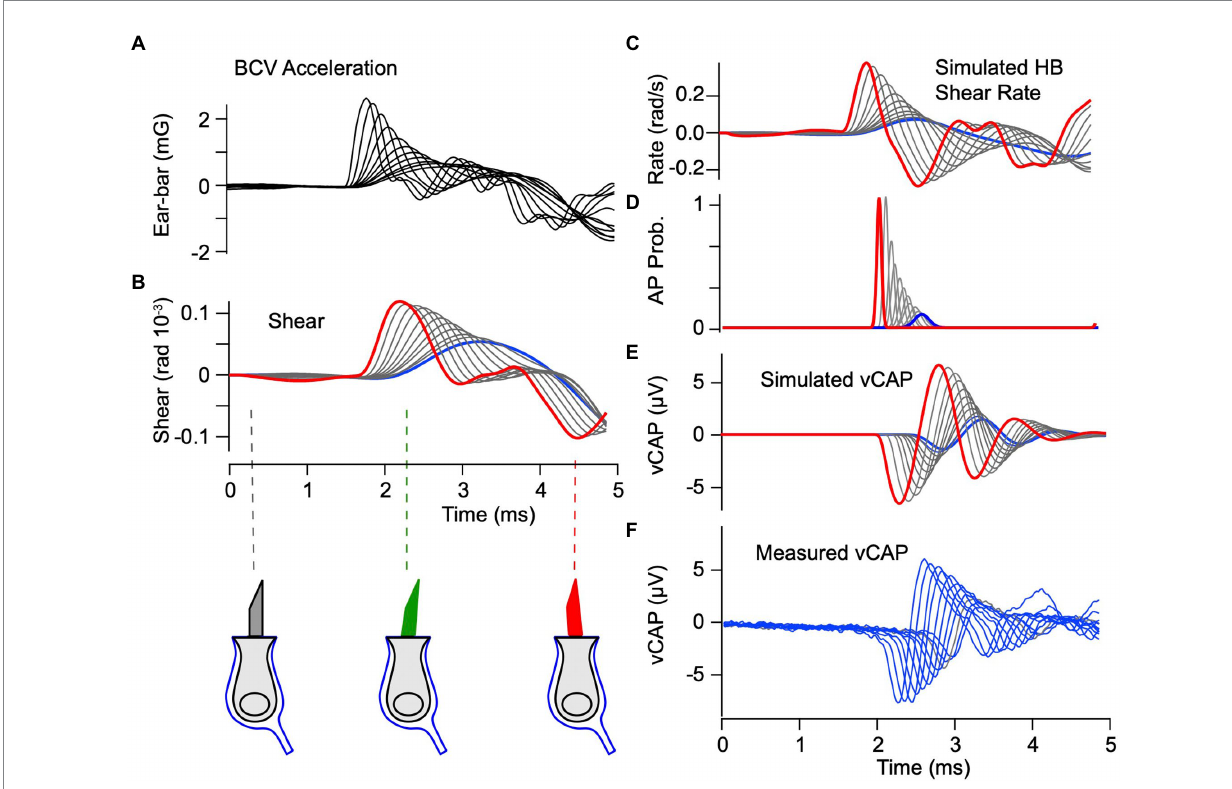
FIGURE 5 vCAP evoked by BCV: Theory vs. Experiment. (A) Experimentally measured ear-bar acceleration used as the input to the simulations. (B) Simulated shear driving hair bundles, which is predicted to have a peak magnitude of ~10 − 4 radians. Red curves indicate the highest strength stimulus and blue curves indicate the lowest strength. Direction and magnitude of hair bundle deflection is indicated below panel B . (C) Shear rate (time derivative of shear in panel B ) driving the IAF model for phase locking afferent neurons. (D) Normalized probability of evoking an action potential as a function of time, where the magnitude corresponds to the number of units recruited, while the mean and width correspond to the most probable time and the variance. (E) Vestibular compound action potentials (vCAPs) simulated by convolving action potential probability with the field potential kernel (Eq. 12). (F) vCAPs measured in the anaesthetized guinea pig during the BCV